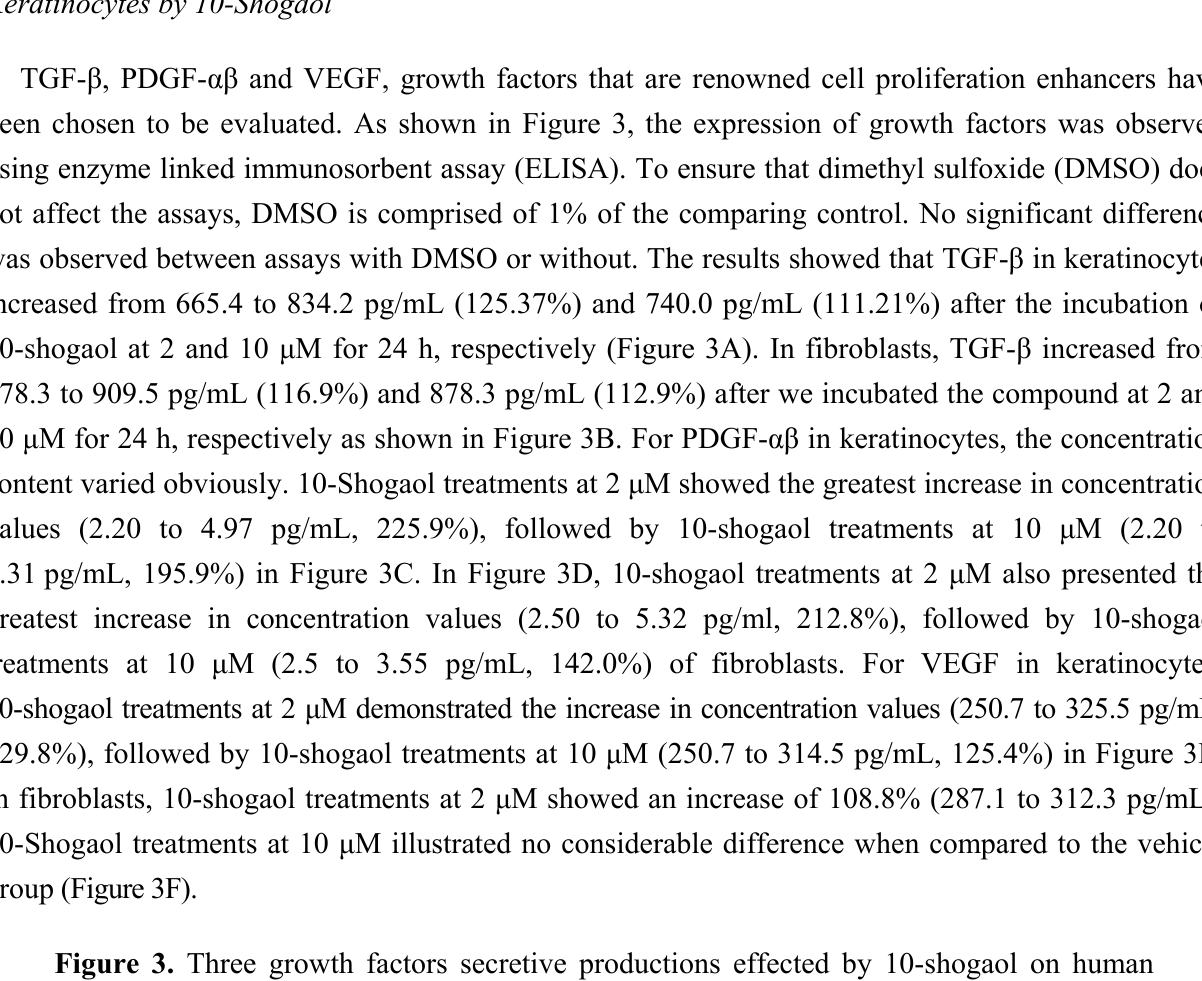
Figure 3. Three growth factors secretive productions effected by 10-shogaol on human skin keratinocytes ( A , C , E ) and fibroblasts ( B , D , F ). The data was shown as mean ± SD of three independent experiments. Significance for three different time-point groups was accepted at * p < 0.05 or ** p < 0.01 versus their corresponding